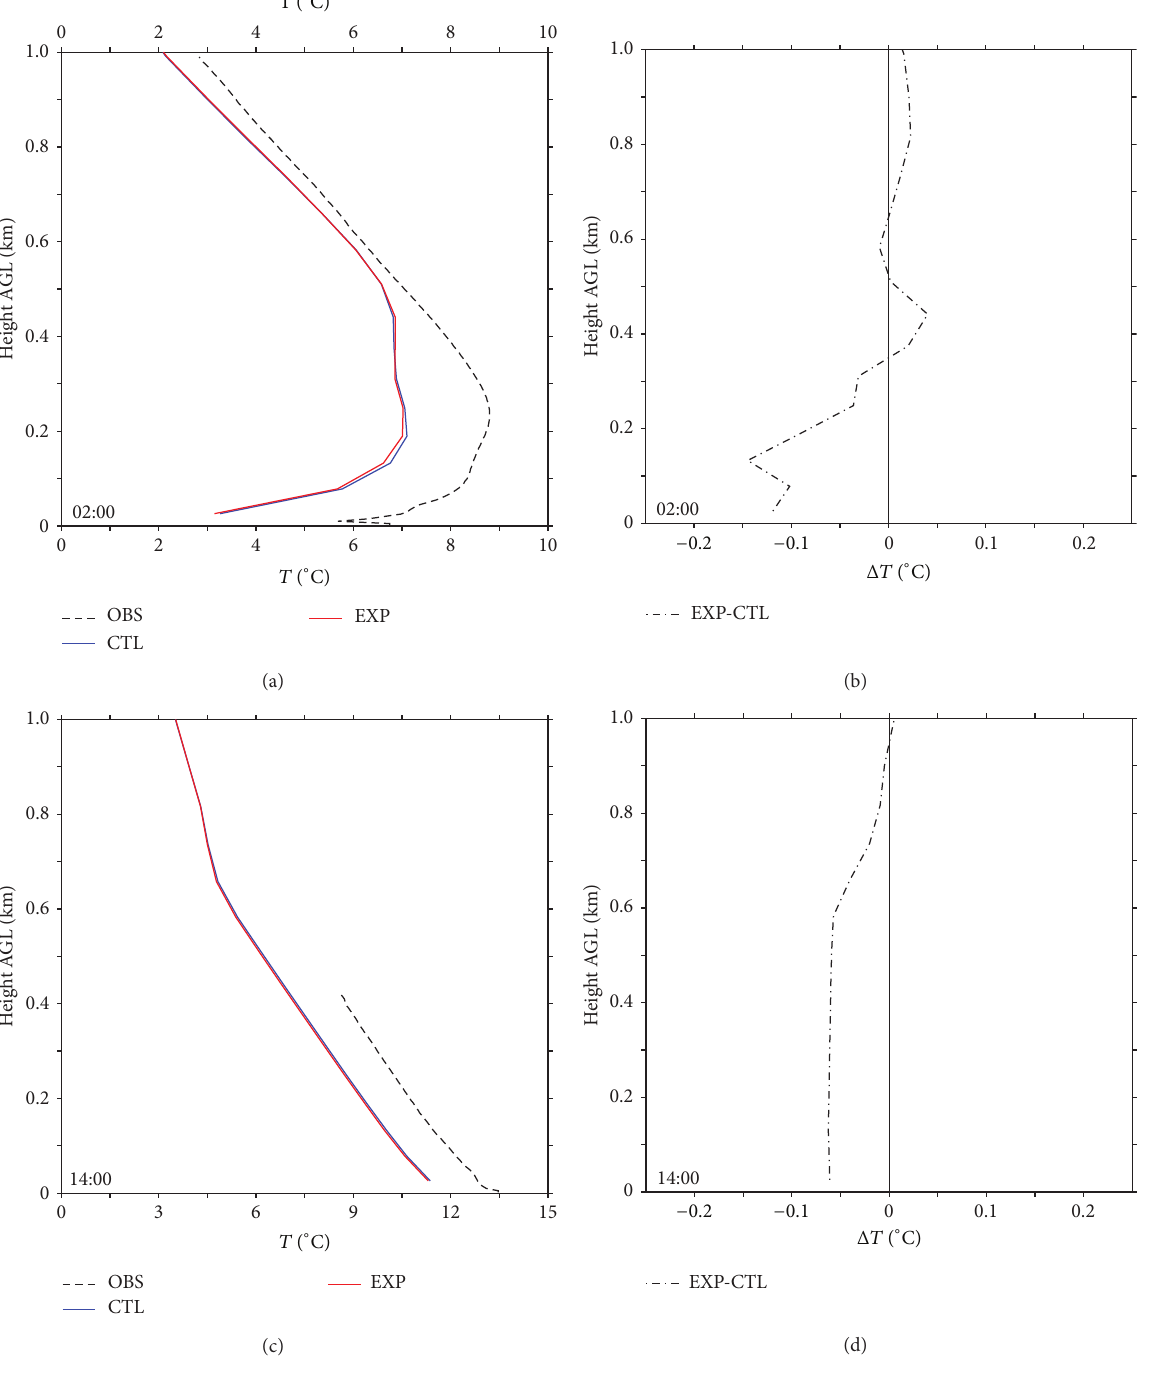
Figure 7: (a) Observed and the simulated mean temperature ( ∘ C) profile at Fangzhuang and (b) differences between the EXP run and the CTL run at 0200 LST 28 February 2001. (c) and (d) are, respectively, the same as (a) and (b), but for 1400 LST 28 February